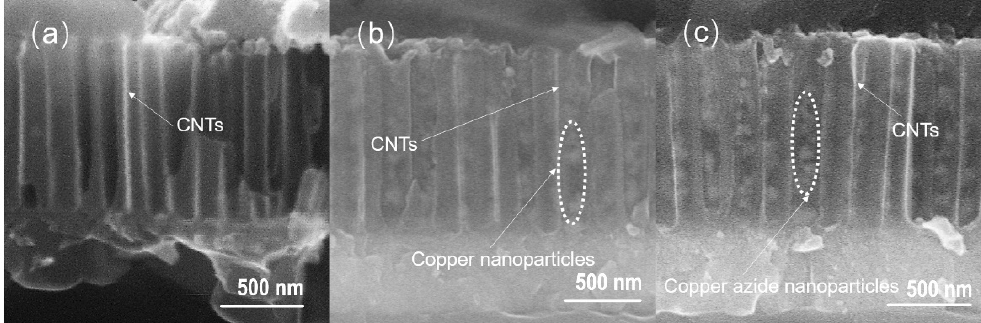
Figure 19. SEM images of the cross‐section of ( a ) CNTs grown on silicon‐based porous alumina films; ( b ) the silicon‐based Cu@CNTs film and ( c ) the silicon‐based Cu(N 3 ) 2 @CNTs film.